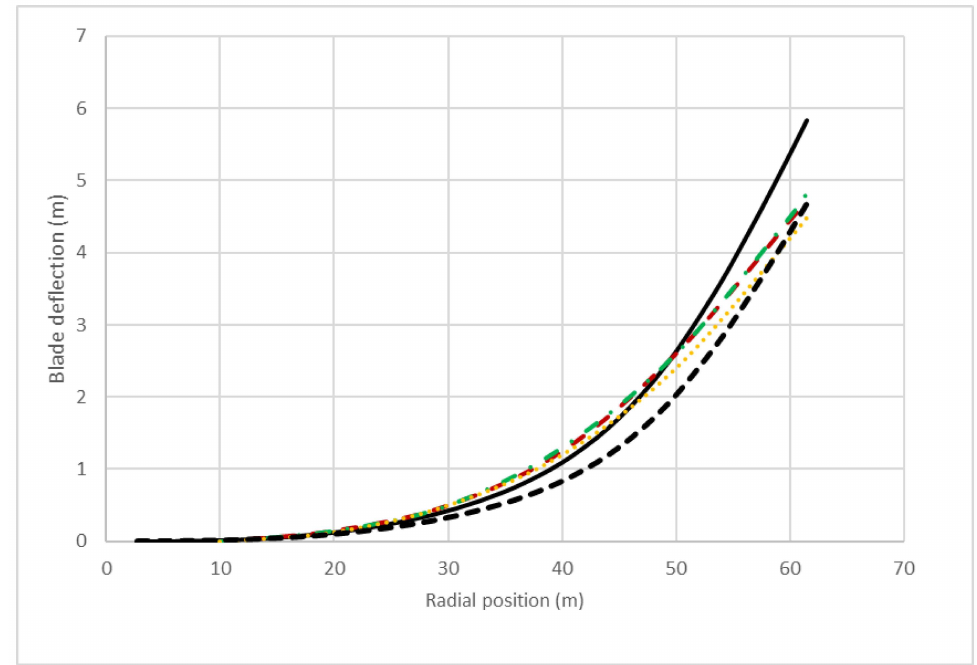
Figure 10. Blade deflection in the flap-wise due to the aerodynamic loading; The two sets of results for the present work were calculated for angular speeds Ω = 0 RPM (solid line) and 12.1 RPM (black dashed line); compared with the yellow dotted line (data adapted from [20]), the green dash-dotted line (data adapted from [32] where BEM-ABAQUS was applied) and the red dashed line (data adapted from [29] where CFD-CSD was